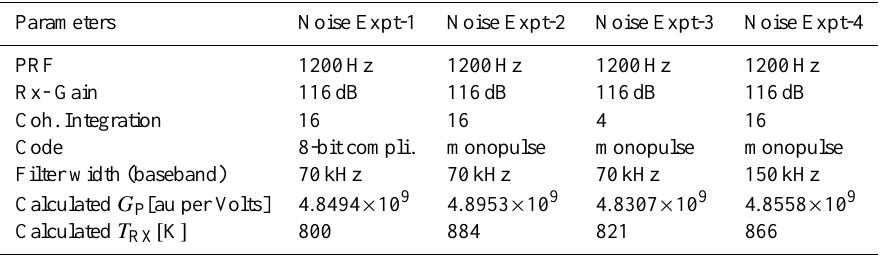
Table 1. The selection of parameters for four noise generator experiments (upper portion of table) along with the calculated system voltage gain and receiver noise temperature values for the Resolute Bay radar (lower portion of table). Different values of pulse coding, coherent integration and filter widths are deliberately chosen in order to test the theory. Parameters Noise Expt-1 Noise Expt-2 Noise Expt-3 Noise Expt-4 PRF 1200Hz 1200Hz Rx- Gain 116dB 116dB 116dB 116dB Coh. Integration Code 8-bit compli. Filter width